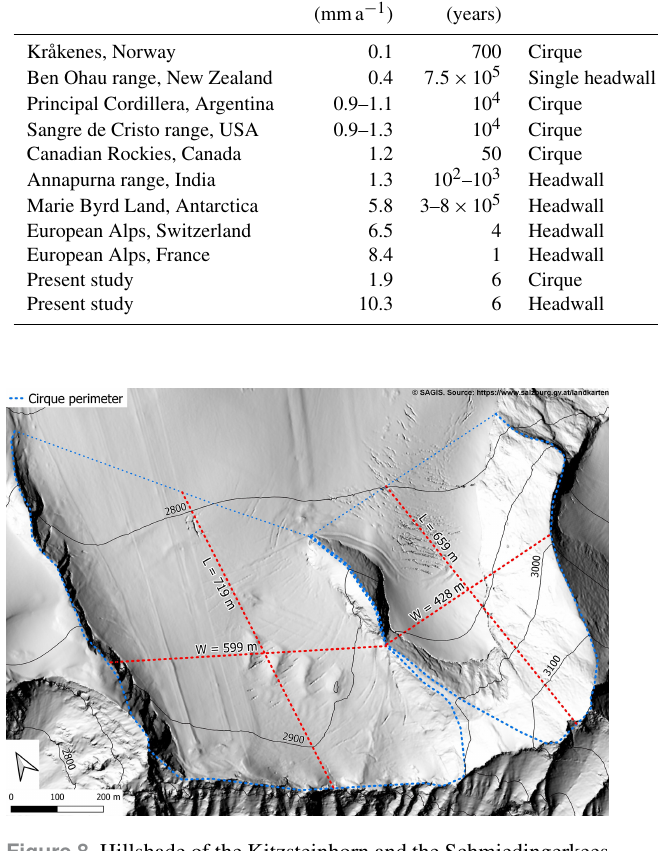
Figure 8. Hillshade of the Kitzsteinhorn and the Schmiedingerkees glacier. Length (L) and width (W) of the two cirques indicated (red dotted lines). Both cirques display a clear north–south elongated shape with high L / W ratios (1.2 for the western cirque, 1.5 for the eastern cirque) indicating effective cleavage-driven headward cirque erosion (north faces) over extended time